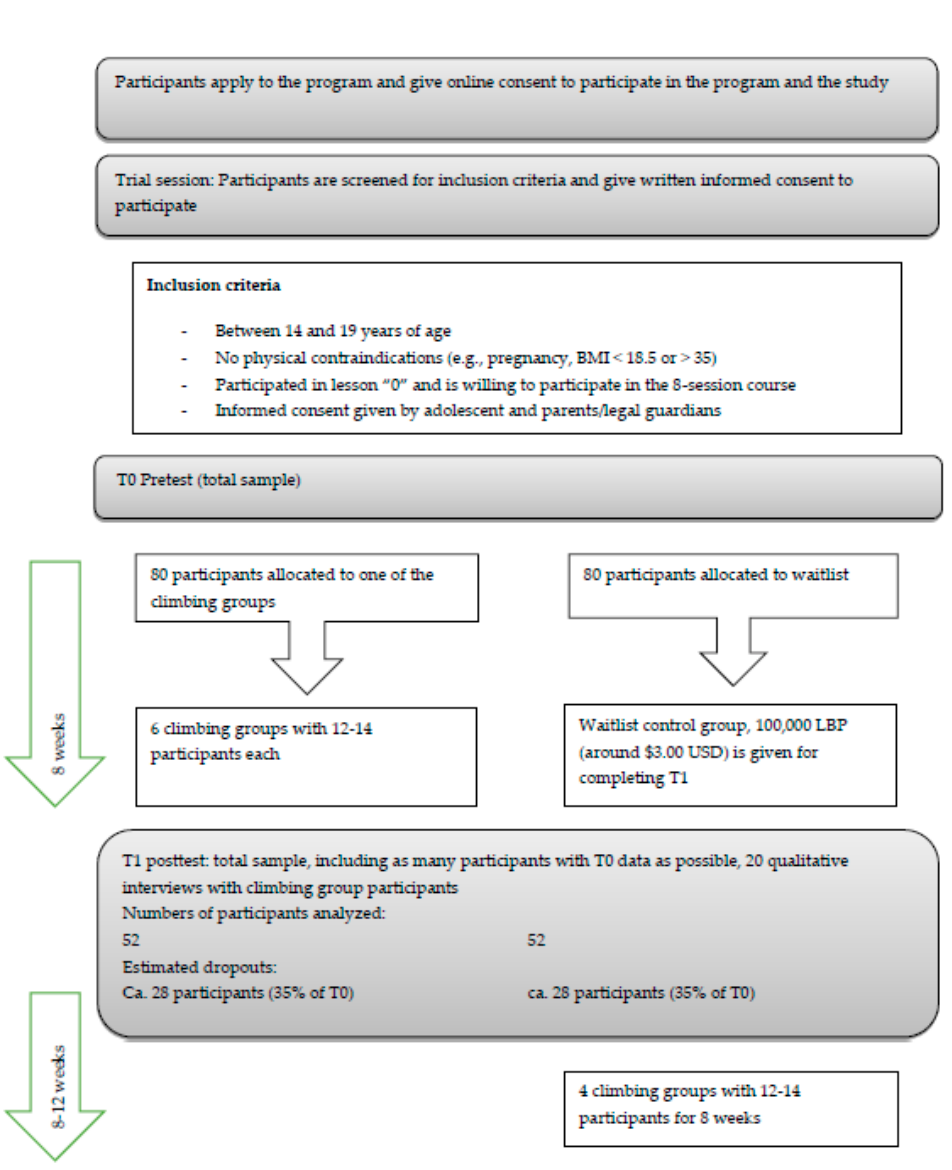
Figure 2. Consort Flow Chart With Estimated Numbers of Participants.